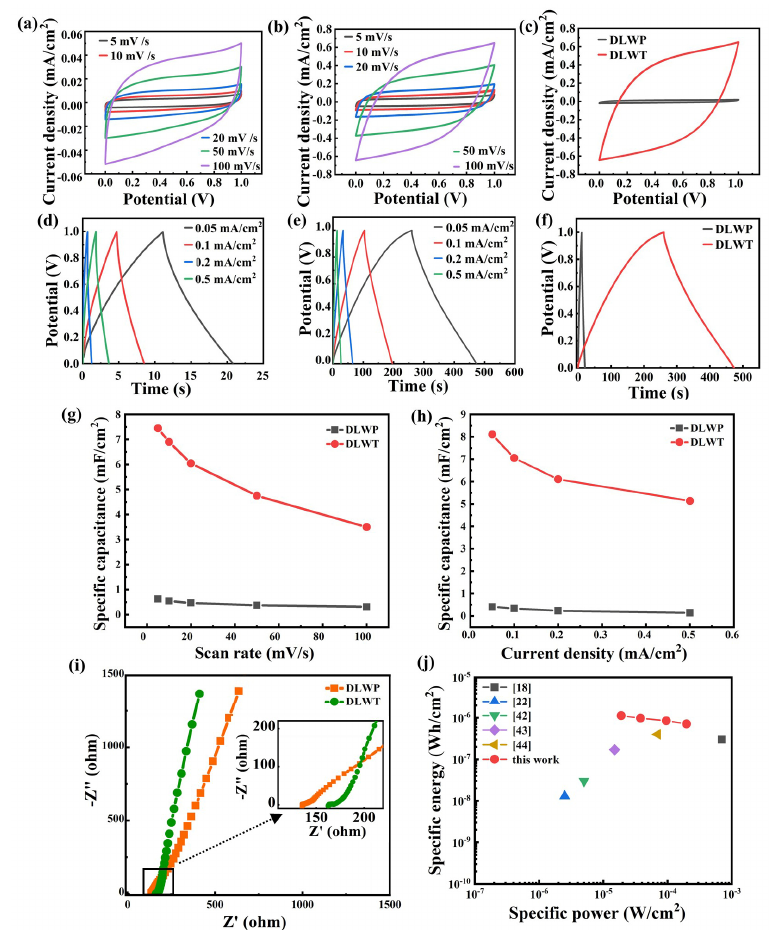
Figure 4. The cyclic voltammetry (CV) curve of ( a ) DLWP and ( b ) DLWT with the scan rates of 5, 10, 20, 50, and 100 mV/s; ( c ) the CV curve comparison between DLWT and DLWP (scan rates is 100 mV/s); The galvanostatic charge/discharge (GCD) curve of ( d ) DLWP and ( e ) DLWT with the current density of 0.05, 0.1, 0.2, and 0.5 mA/cm 2 ; ( f ) the GCD curve comparison of DLWT and DLWP (current density is 0.05 mA/cm 2 ); specific capacitance ( g ) calculated from CV data ( h ) calculated from GCD data; ( i ) the Nyquist plots of DLWP and DLWT; ( j ) Ragone plot.